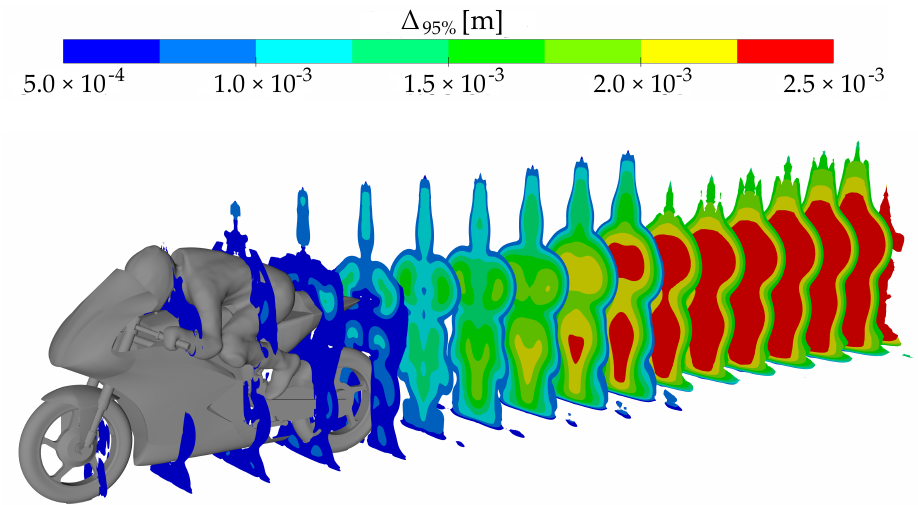
Figure 5. Predicted mesh size for high-quality DDES in cross-sections along the motorbike and its